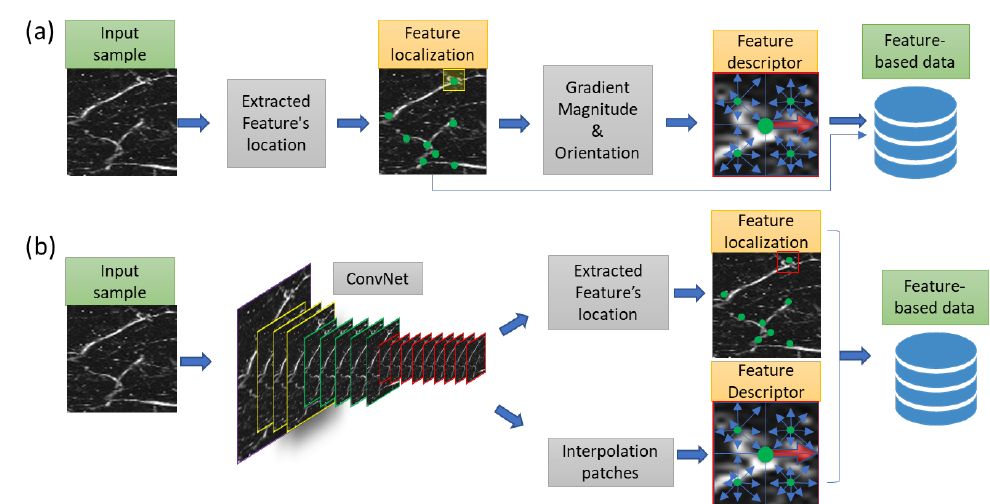
Figure 1. Feature generation process for mosaic photoacoustic microscopy images. ( a ) Traditional interest feature generation approach, ( b ) deep interest feature generation approach.